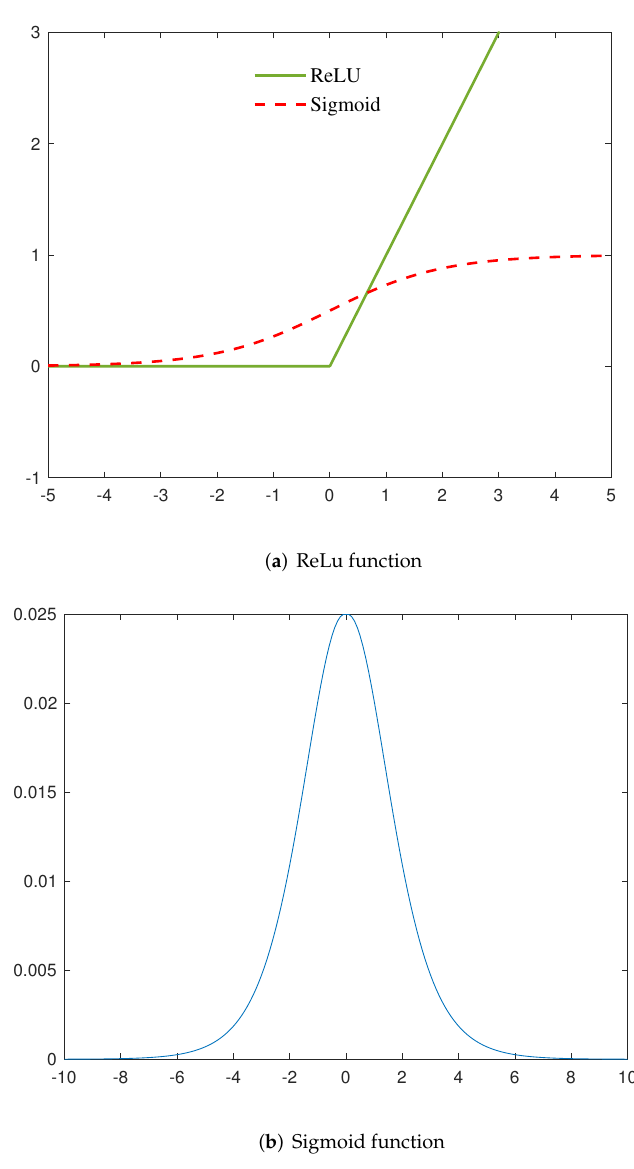
Figure 4. Schematic diagram of the activation